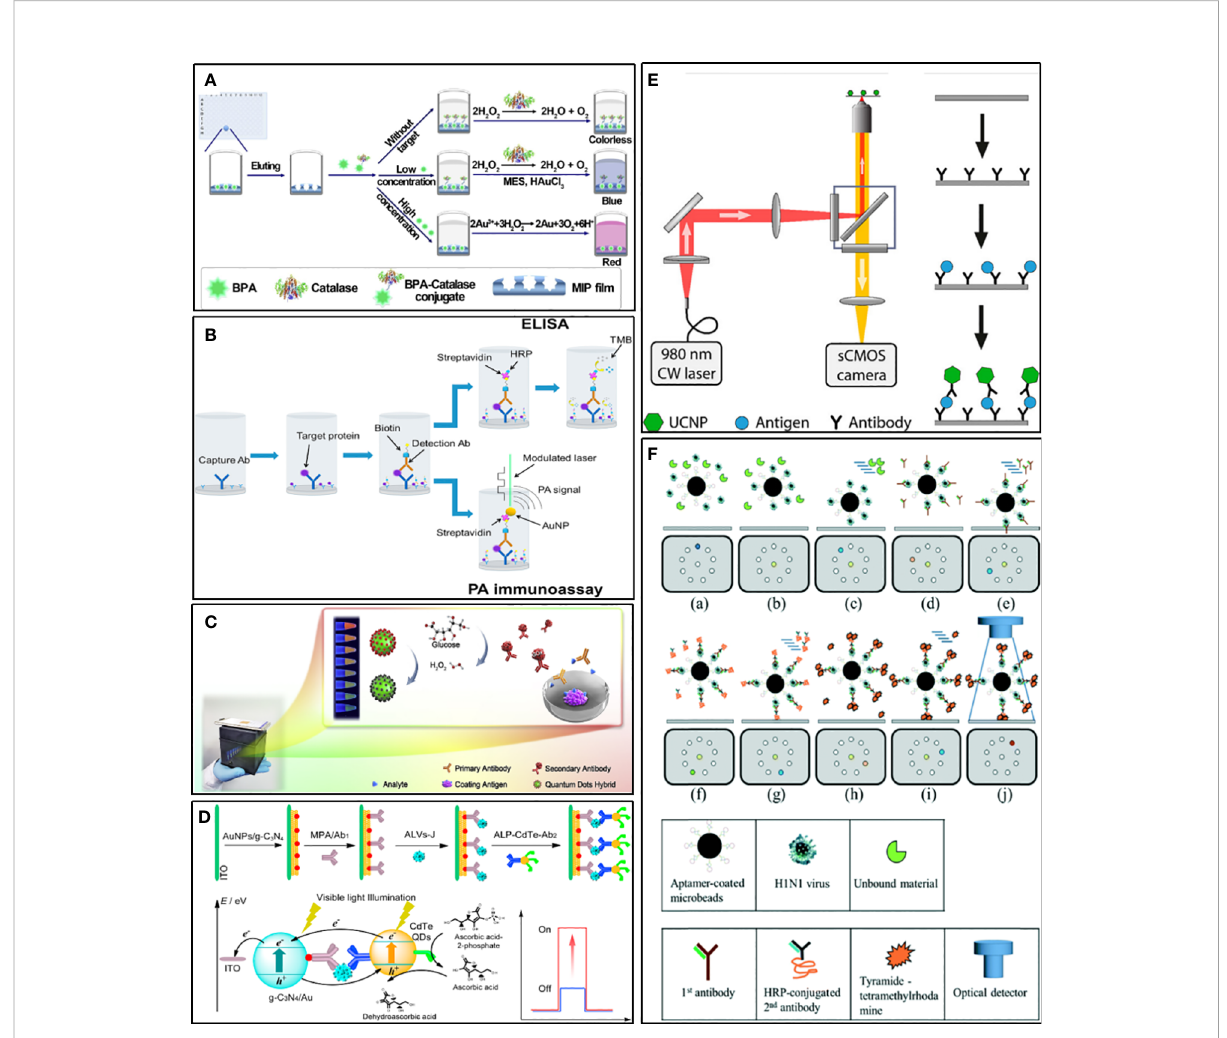
FIGURE 5 Examples of strategies for improving sensitivity. (A) Schematic illustration for ELISA combines MIP with catalase-mediated growth of plasma AuNPs (Jia et al., 2021). (B) Schematic diagram of an ELISA in which SA-HRP is replaced by an SA-bound AuNP and no TMB substrate is used (Zhao et al., 2016). (C) Schematic diagram of the ratiometric fl uorescent sensing system integrated of a ratiometric quantum dots (QDs) hybrid and chemical redox reaction for drug residue analysis (Yu et al., 2020). (D) Schematic illustration for photoelectrochemical immunosensor based on AuNPs/g-C3N4 coupling with CdTe quantum dots for detection of target avian viruses (Sun et al., 2019). (E) Scheme of ULISA for counting single molecules of PSA (Farka et al., 2017). (F) Schematic diagram of in fl uenza virus diagnostic process using magnetic beads in a structure-free digital micro fl uidic platform (Lu et al.,